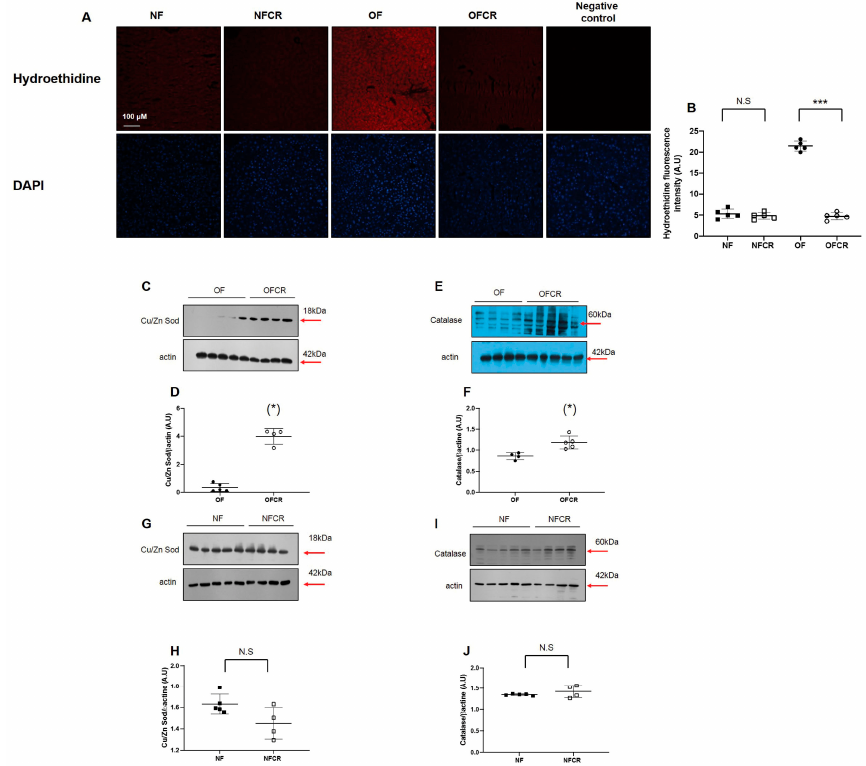
Figure 2. Liver superoxide anion production and antioxidant defense protein expression in the NF, NFCR, OF, and OFCR groups at seven months of age. Superoxide anion production was measured by hydroethidine staining ( A ) at the same magnification (20×) in the NF, NFCR, OF, and OFCR groups. Nuclei were counterstained with DAPI. A negative control was included. Hydroethidine fluorescence intensity was quantified using ImageJ ( B ). *** p < 0.001, N.S: nonsignificant, p > 0.05. These pictures are representative images from n = 5 animals/group. Cu/Zn superoxide dismutase (Cu/Zn Sod) ( C and D ) and catalase ( E and F ) protein expression levels were measured by western blot in the OF and OFCR groups. Cu/Zn superoxide dismutase (Cu/Zn Sod) ( G and H ) and catalase ( I and J ) protein expression levels were also measured by western blot and in the NF and NFCR groups. Values are reported as the mean ± SD; (*) p < 0.05; N.S : nonsignificant, p > 0.05; n = 5–4 dash (–).animals/group.